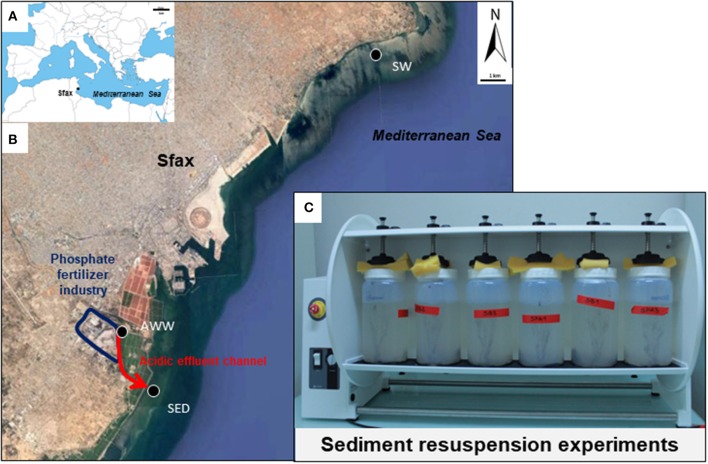
Map of the study area in the south Mediterranean Sea (A) and in the Sfax coast (B) and photograph of the laboratory experiments of sediment resuspension (C). Location of sampling sites is shown by black circles. Location of the fertilizer plant in the industrial area is indicated in blue. Red arrows indicate the direction of flow of acidic wastewater.